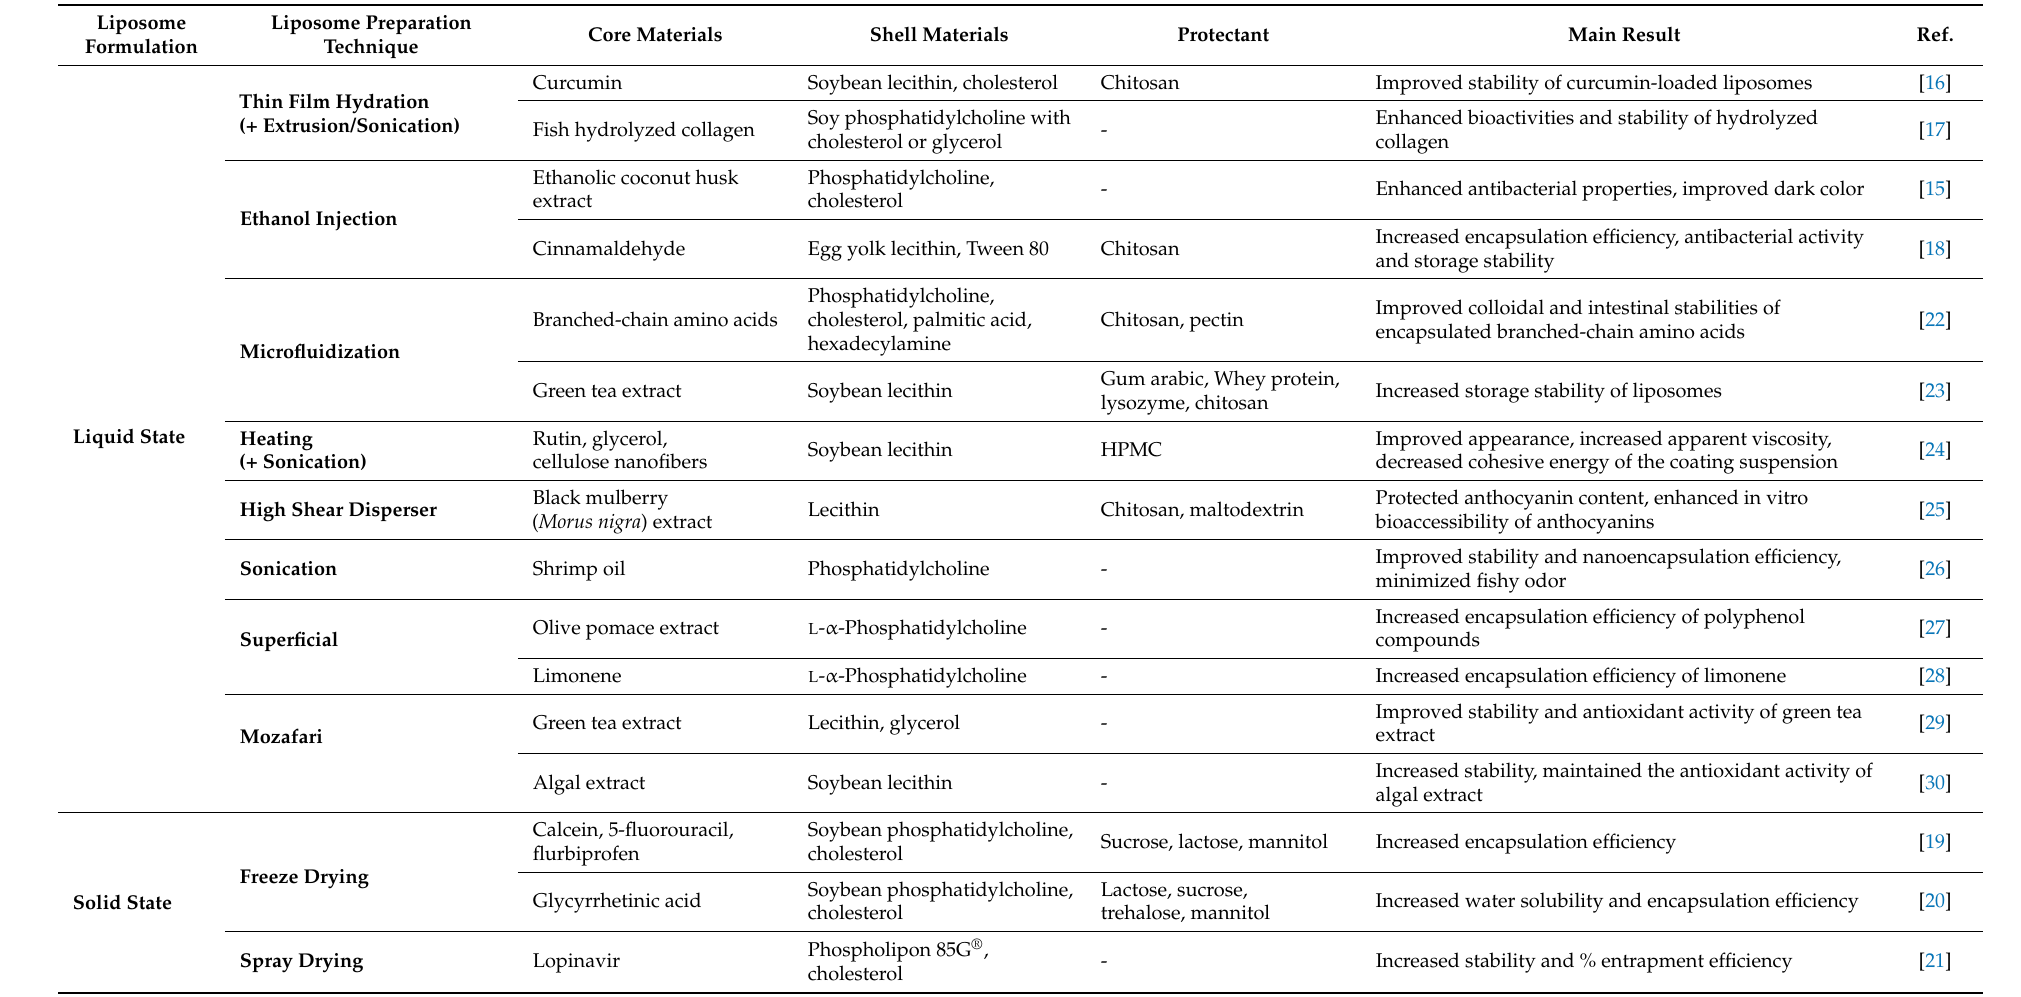
Table 1. Preparation techniques and recent studies of